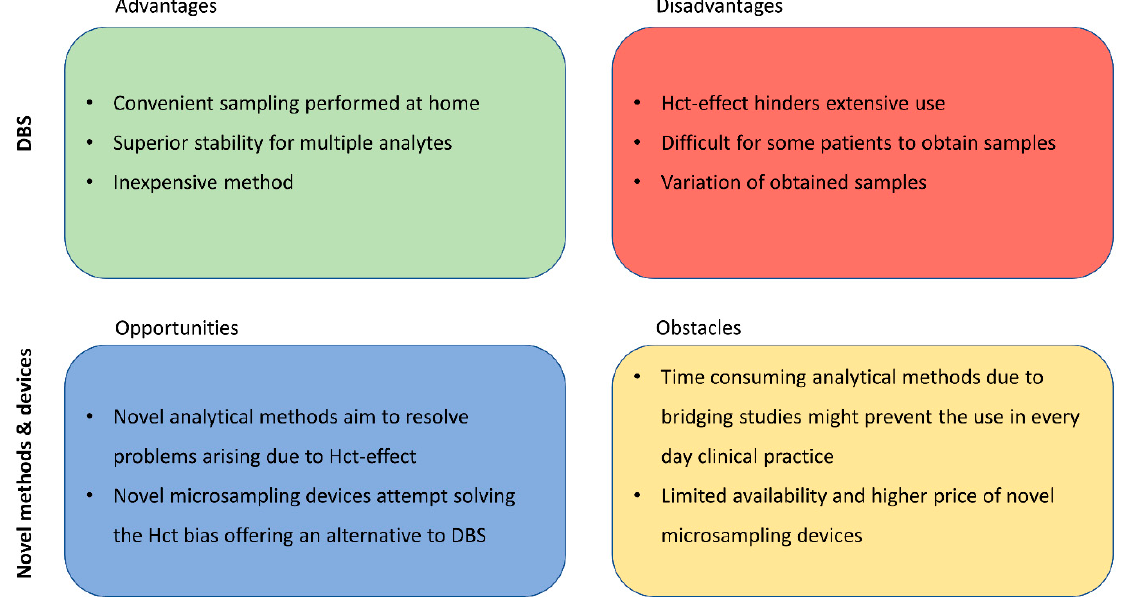
Figure 2. Current role of DBS compared to novel methods and devices.